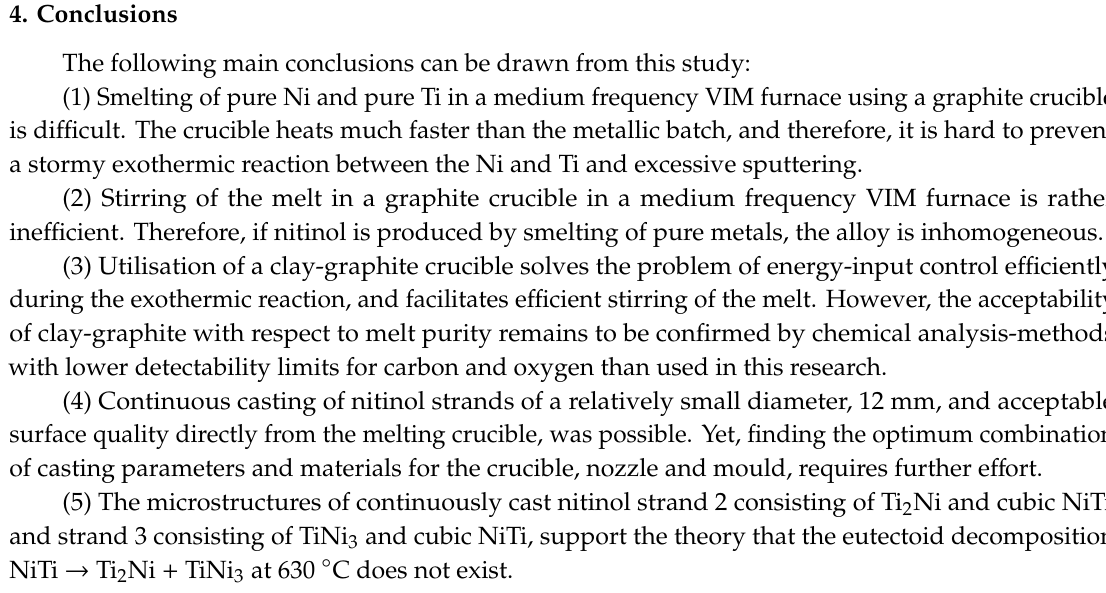
Figure 7. Microstructure of strand 3. SEM image. Two phases were observed. Strongly prevailing cubic NiTi (grey), cubic NiTi 2 (dark, almost black). Kikuchi patterns of NiTi and NiTi 2 , obtained by the EBSD system, are presented on the top.